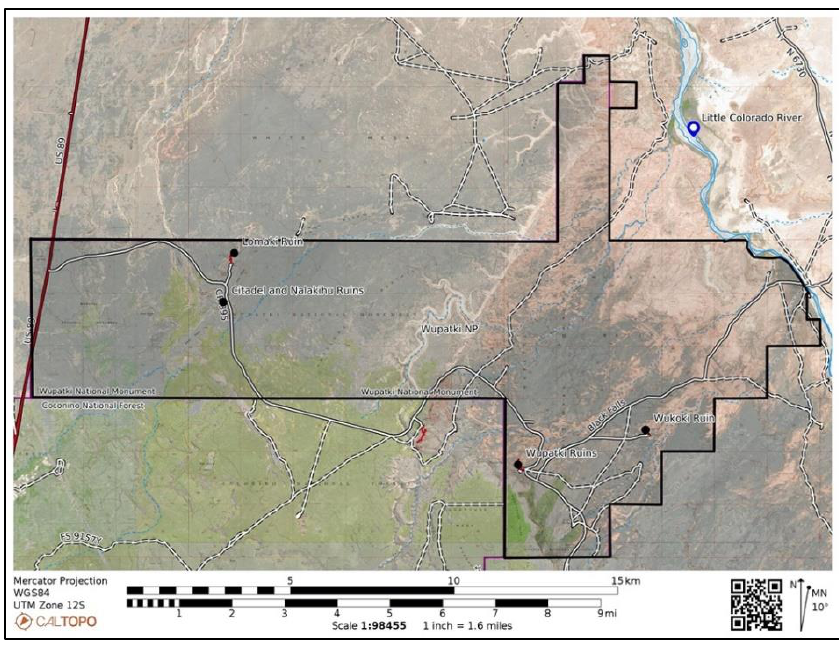
Figure 10. Map of Wupatki National Monument.